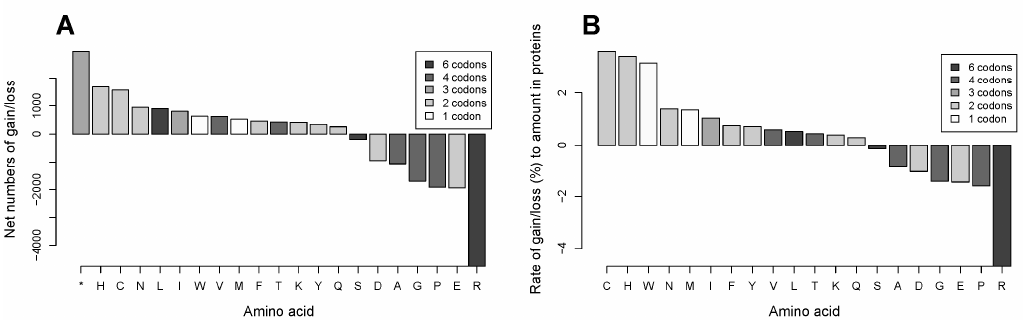
Figure 3. Gain and loss of amino acids in substitutions in the CCLE database. ( A ) Net frequencies of gain/loss of amino acids in the analyzed proteome subset in the 782 cancer cell lines; and ( B ) Rate of gain/loss for each amino acid as the ratio of the net frequencies of its gain/loss to its amount in the 2164 proteins.